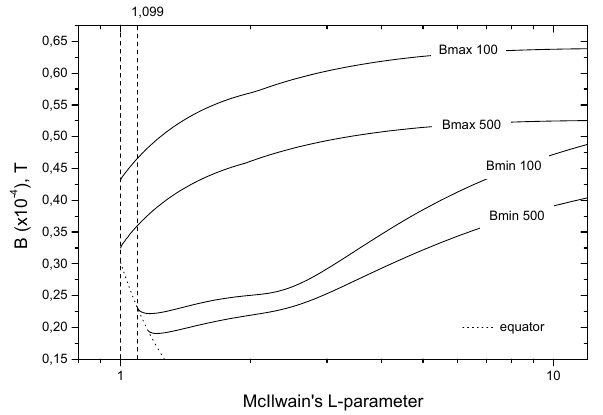
Fig. 2. The longitude spread of northern (dot) and southern (solid) magnetic mirror points, both at 100 (red) and 500km (black) alti- tudes at magnetic shell L = 1. The solid horizontal line indicates the magnetic equator in dipole approximation (i.e. no longitude depen-